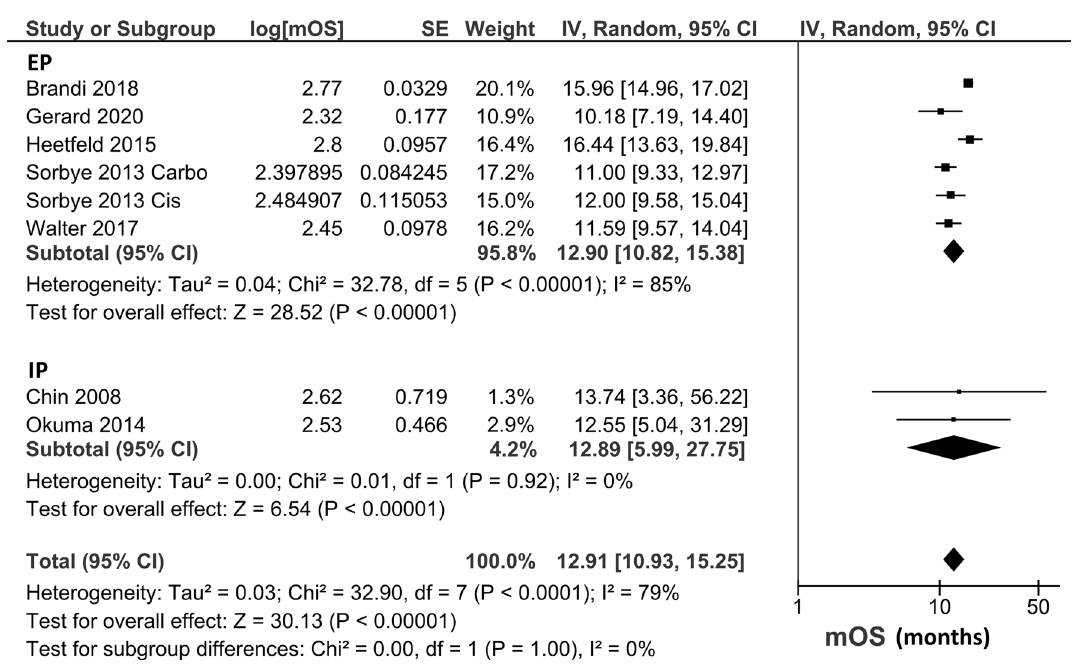
Fig. 5 Pooled median OS in patients treated with platinum-doublet chemotherapy. Five studies that evaluated patients treated with EP and two studies that evaluated patients with IP were included in this analysis. EP platinum plus etoposide, IP platinum plus irinotecan, OS overall